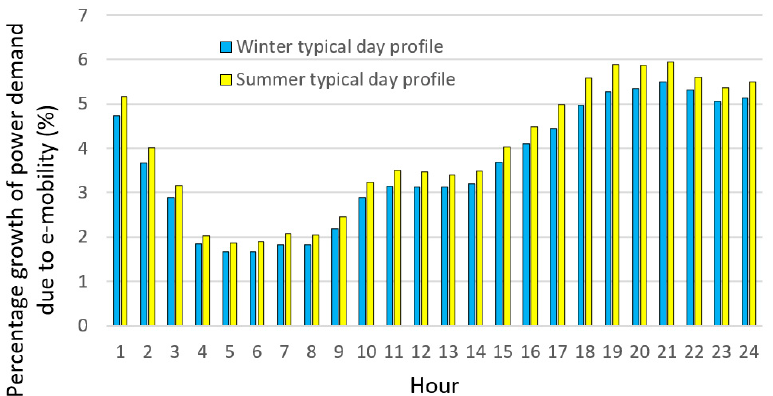
Figure 18. Percentage growth of power demand due to e-mobility for the balanced variant of forecast number of EVs in 2027 for the typical winter and summer days.